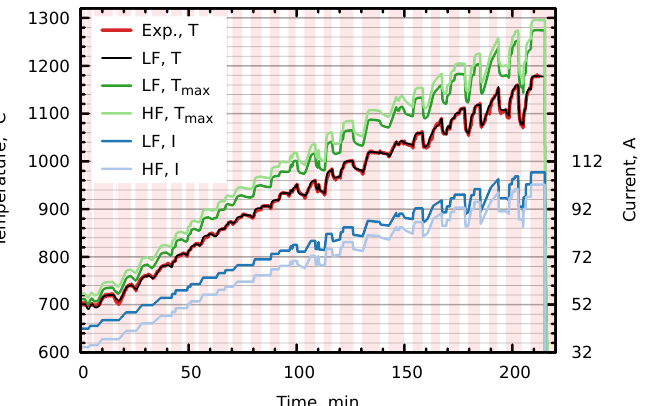
Figure 3. Comparison of time-dependent temperature with experimental measurements. T ( t ) for the HF simulation is not depicted as it practically overlaps with the LF result. Also shown is the maximum crystal temperature T max and inductor current I . Highlighted areas show time intervals at which the crystal is